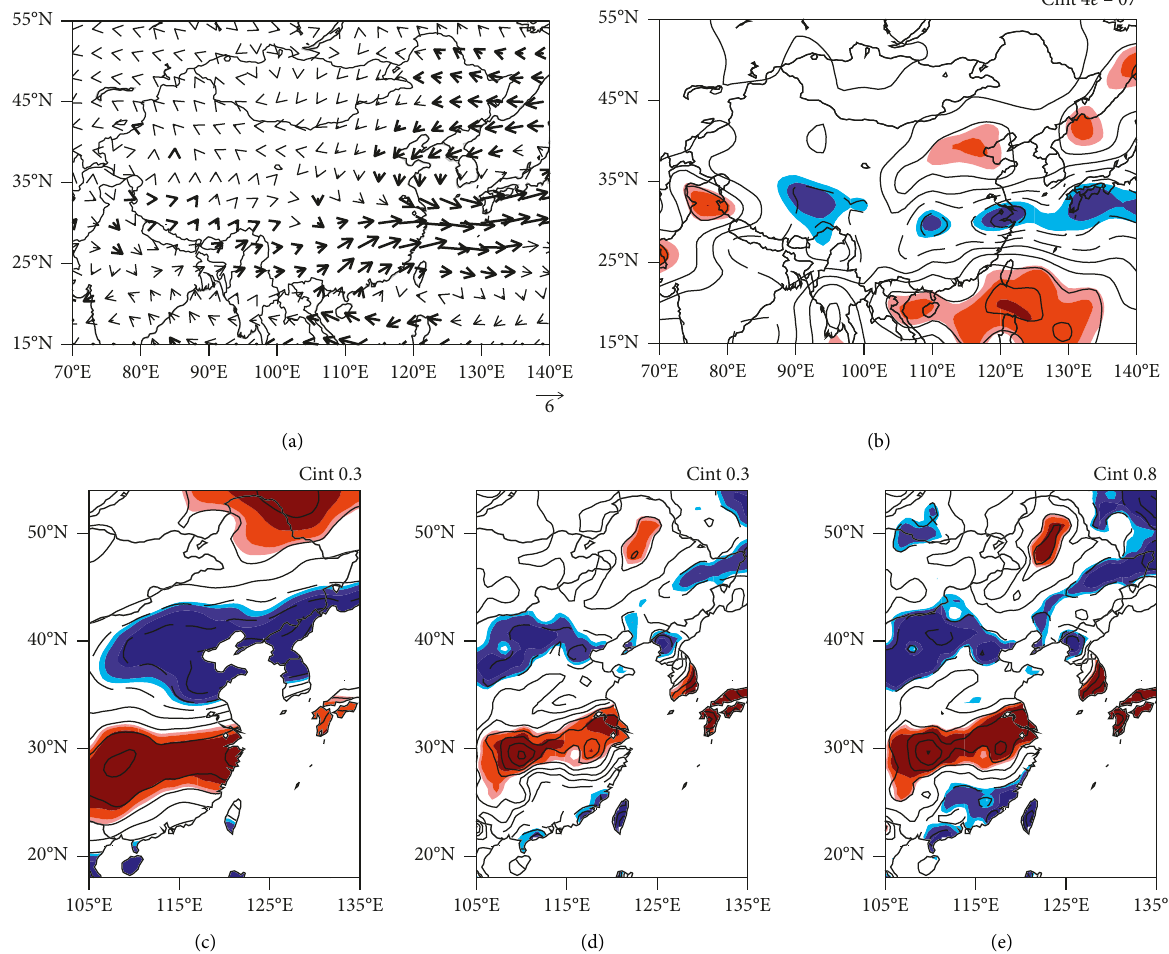
Figure 7: PC2-regressed column-integrated water vapor flux (a) and its divergence (b), total precipitable water (c), precipitation (d), and precipitation efficiency (e) in boreal summer during 1979–1999. Thick vectors in (a) denote the significant areas at the 95% level. Solid (dashed) contours denote positive (negative) anomalies, and red (blue) color shadings from light to dark for significant areas at 90%, 95%, and 99%